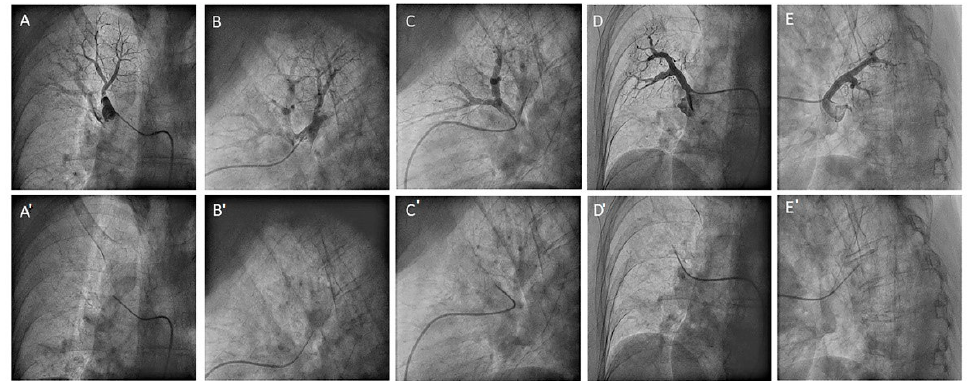
Figure 29. MP catheter canulating the right upper lobe segmental branches, ( A – E ) with contrast and ( A’ – E’ ) without contrast. ( A ) Apical branch (A1), anteroposterior view; ( B ) apical branch (A1), lateral view; ( C ) anterior branch (A3), lateral view; ( D ) posterior branch (A2), anteroposterior view; and ( E ) posterior branch (A2), lateral view.